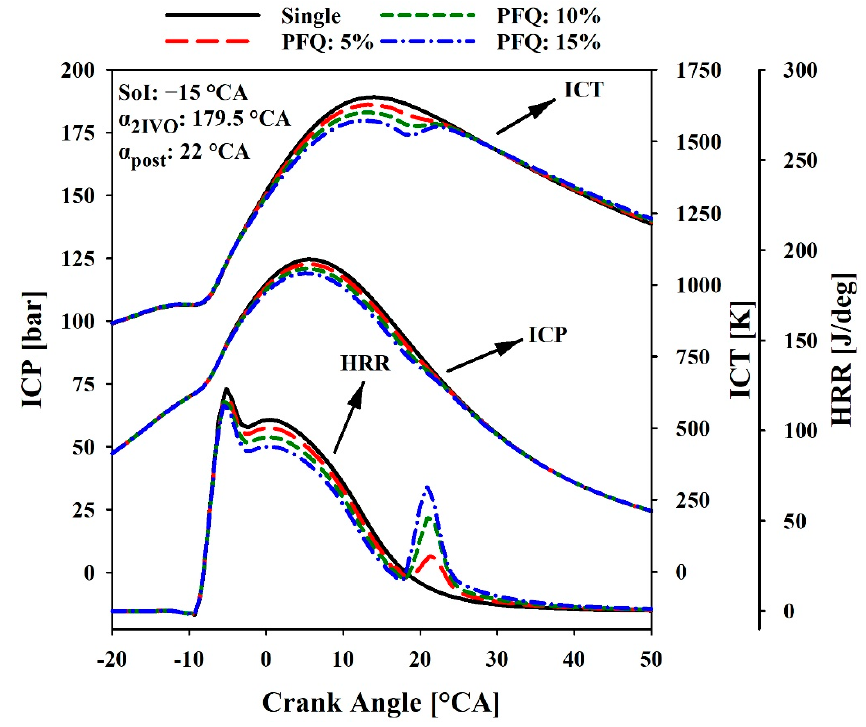
Figure 11. Effect of PFQ on ICP, ICT and HRR pattern .